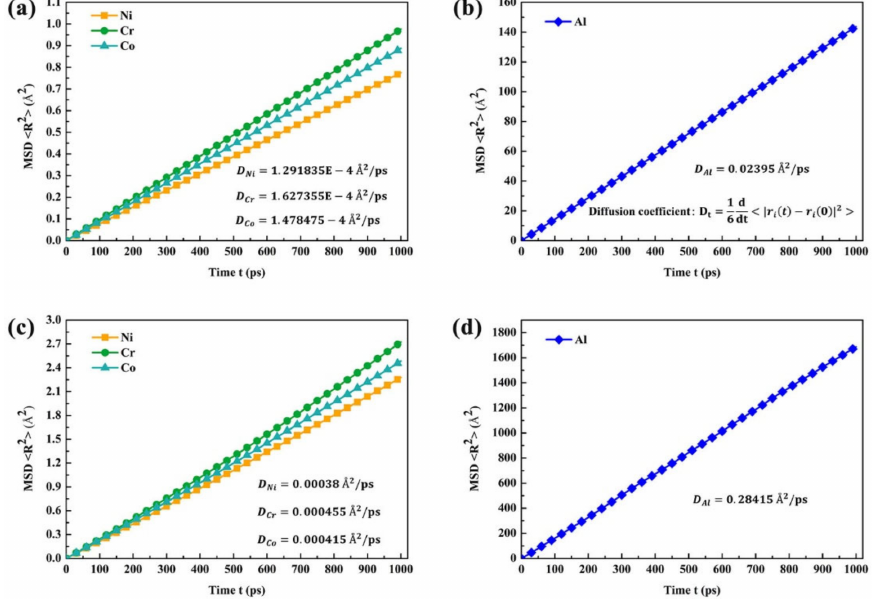
Figure 8. Mean square displacement and diffusion rate ( a , c ) of Ni, Cr, and Co elements, and mean square displacement and diffusion rate ( b , d ) of Al elements of the medium-entropy alloy CrCoNiAl 0.014 at 300 and 700